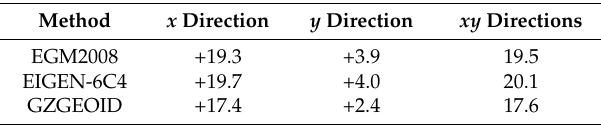
Table 10. Differences between the coordinates of the laser plumbing and GNSS measurements after correction